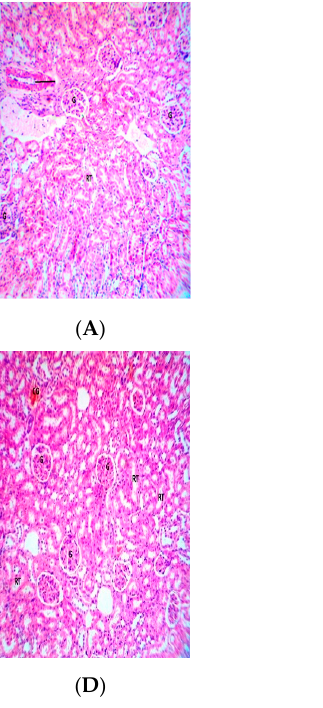
Figure 6: Photomicrograph of kidney section of Wistar rats repeatedly dosed with ( A ) 62.5 mg/kg bw, ( B ) 125 mg/kg bw, ( C ) 250 mg/kg bw of P. dactylifera essential oil and ( E ) control showing intact glomerulus (G), other renal features appear normal and unremarkable (×400 H and E Staining); ( D ) 500 mg/kg bw of P. dactylifera essential oil showing mild congestion (CG).